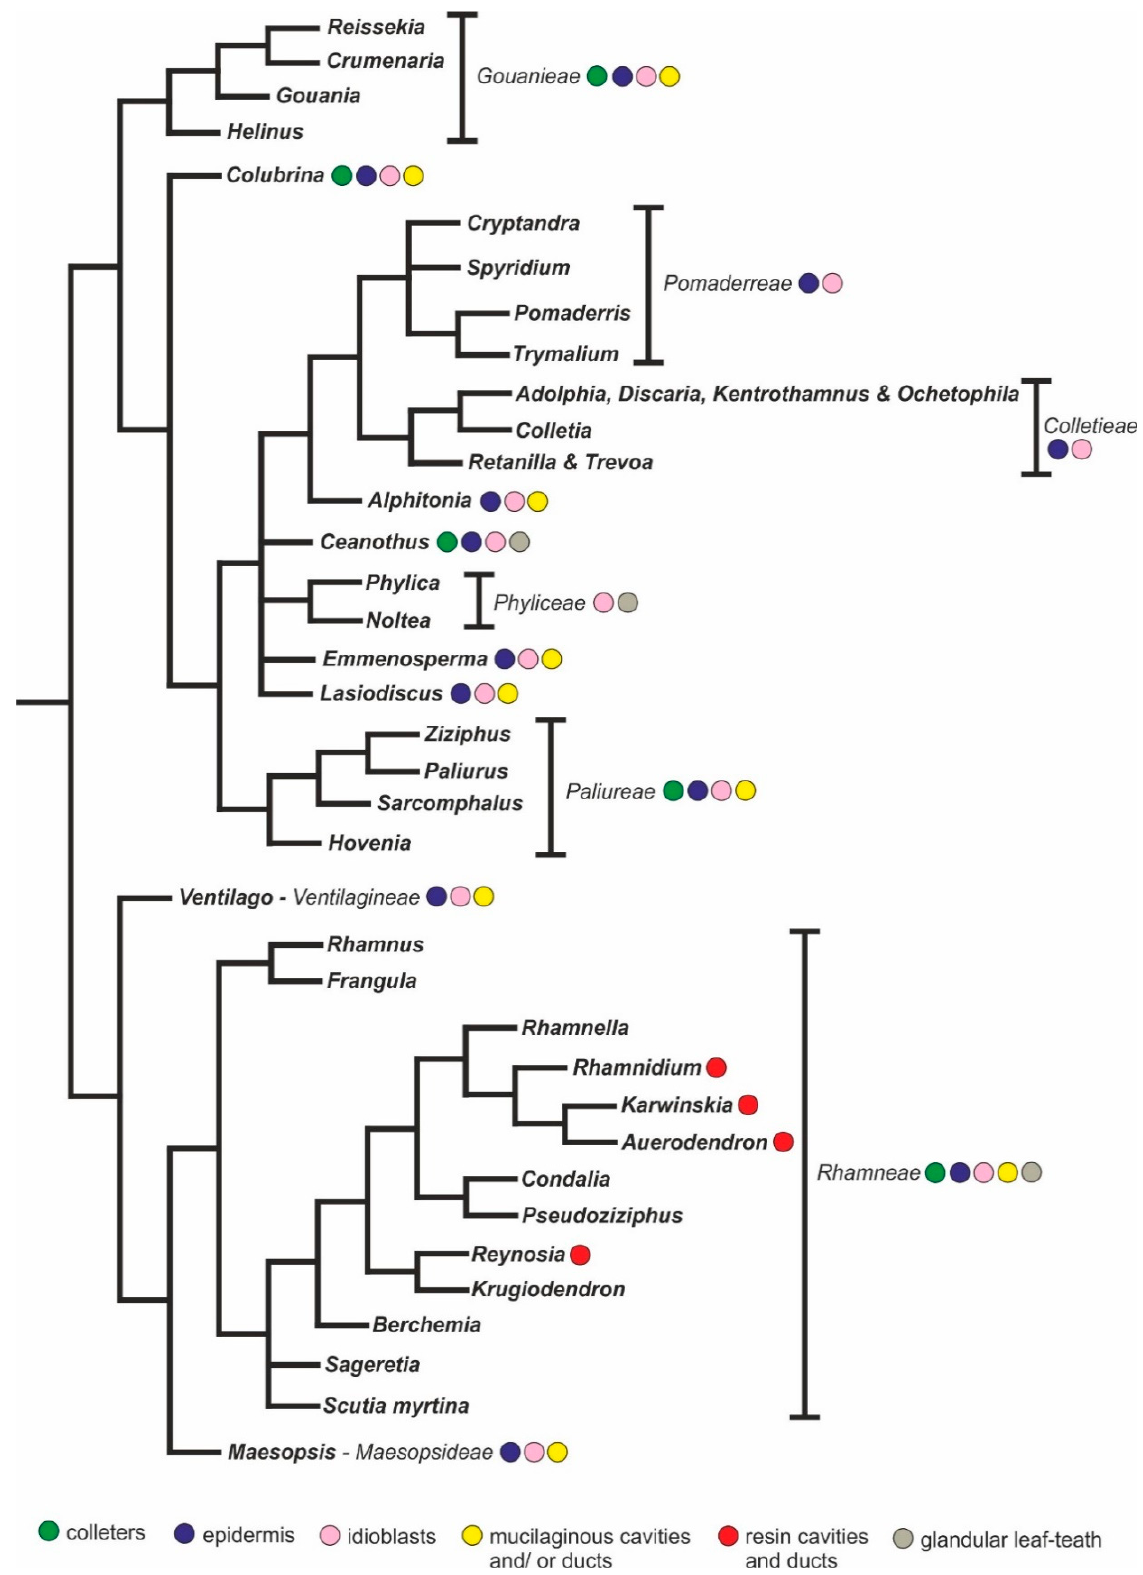
Figure 6. Cladogram based in Hauenschild et al. [45] showing the phylogenetic relations of Rhamnaceae representatives. The occurrence of secretory structures in the Rhamnaceae species is marked in the topography. Data extracted from the literature (see Table S1) and from the present study.